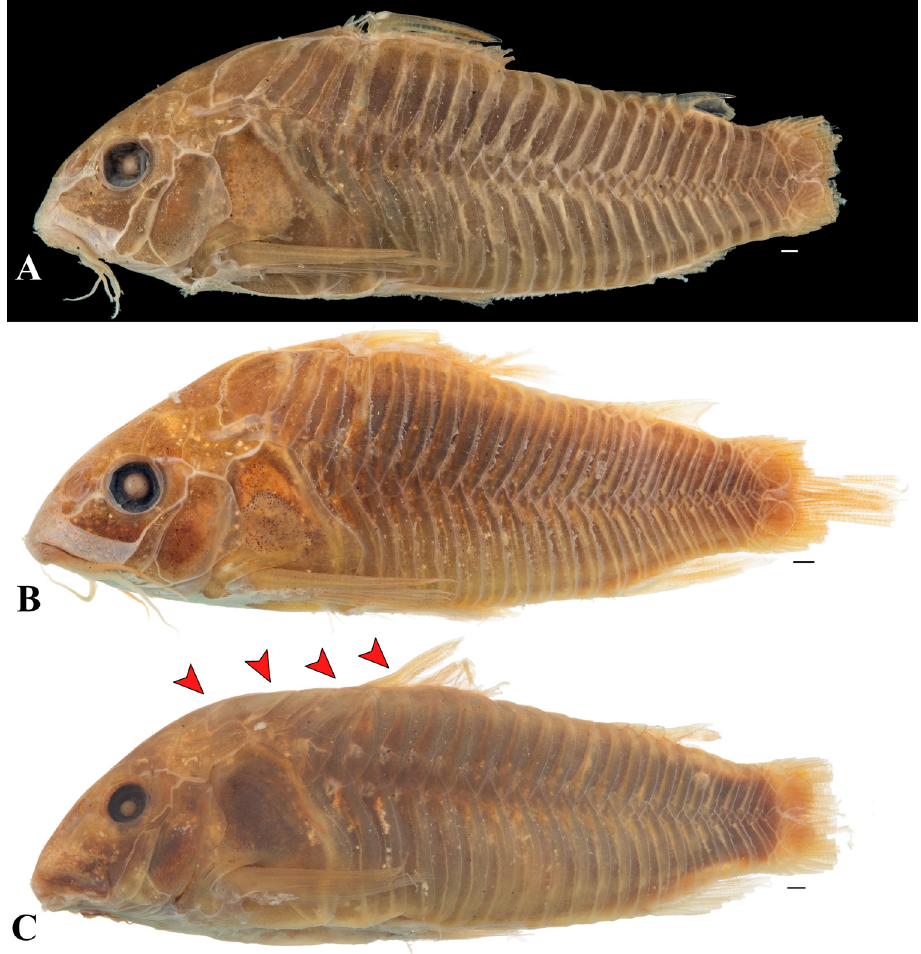
FIGURE 13 | Type specimens of Corydoras aeneus , showing the lectotype ( A , USNM 1116) and paralectotypes ( B , C , USNM 205649 and USNM 92819, respectively) of Hoplosoma aeneum . Red arrows in C indicates the area affected by a malformation on predorsal region of body. Photographs by Sandra Raredon. Scale bar = 1